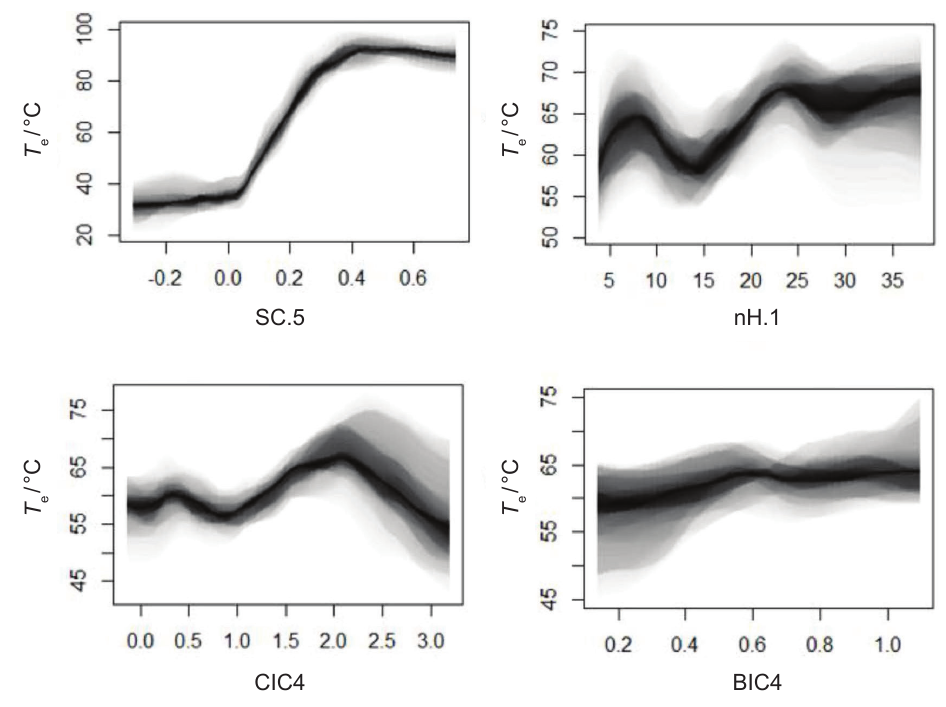
Fig. 3 – Causal plots (partial dependency plots) of the eutectic temperature, T